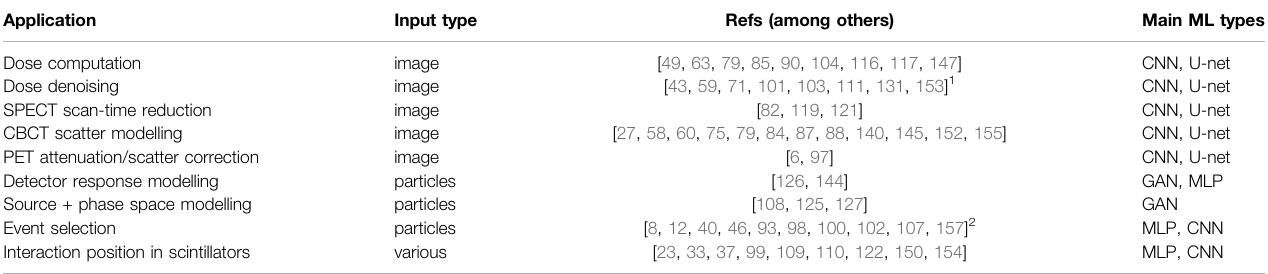
TABLE 1 | AI-based applications related to Monte Carlo simulations and their corresponding input data type. The word “ particles ” as input type refers to a vector of particle properties such as energy, position, direction, weight, etc. CNN stands for convolutional neural networks and MLP stands for multi-layer perceptron. Application Input type Refs (among others)